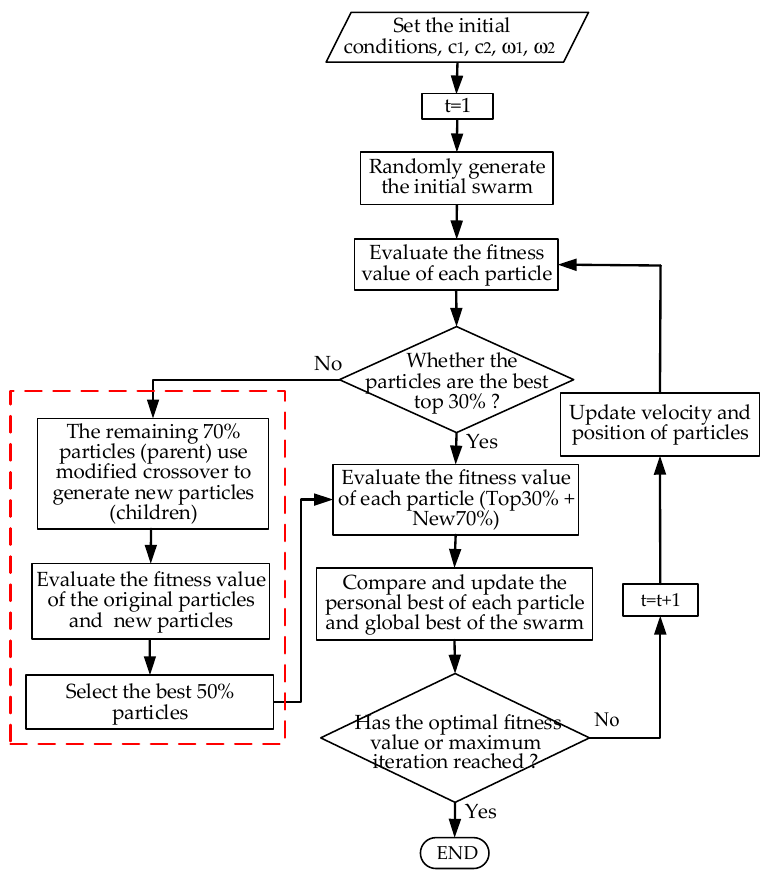
Figure 5. Flow chart of the HPSO algorithm.